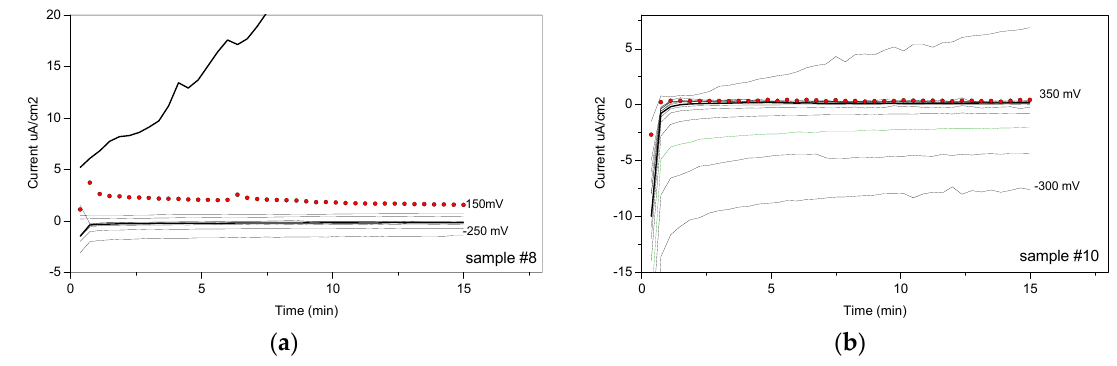
Figure 12. The crevice test potentiostatic curves for the longitudinal surface of sample #8 ( a ) and #10 ( b ).